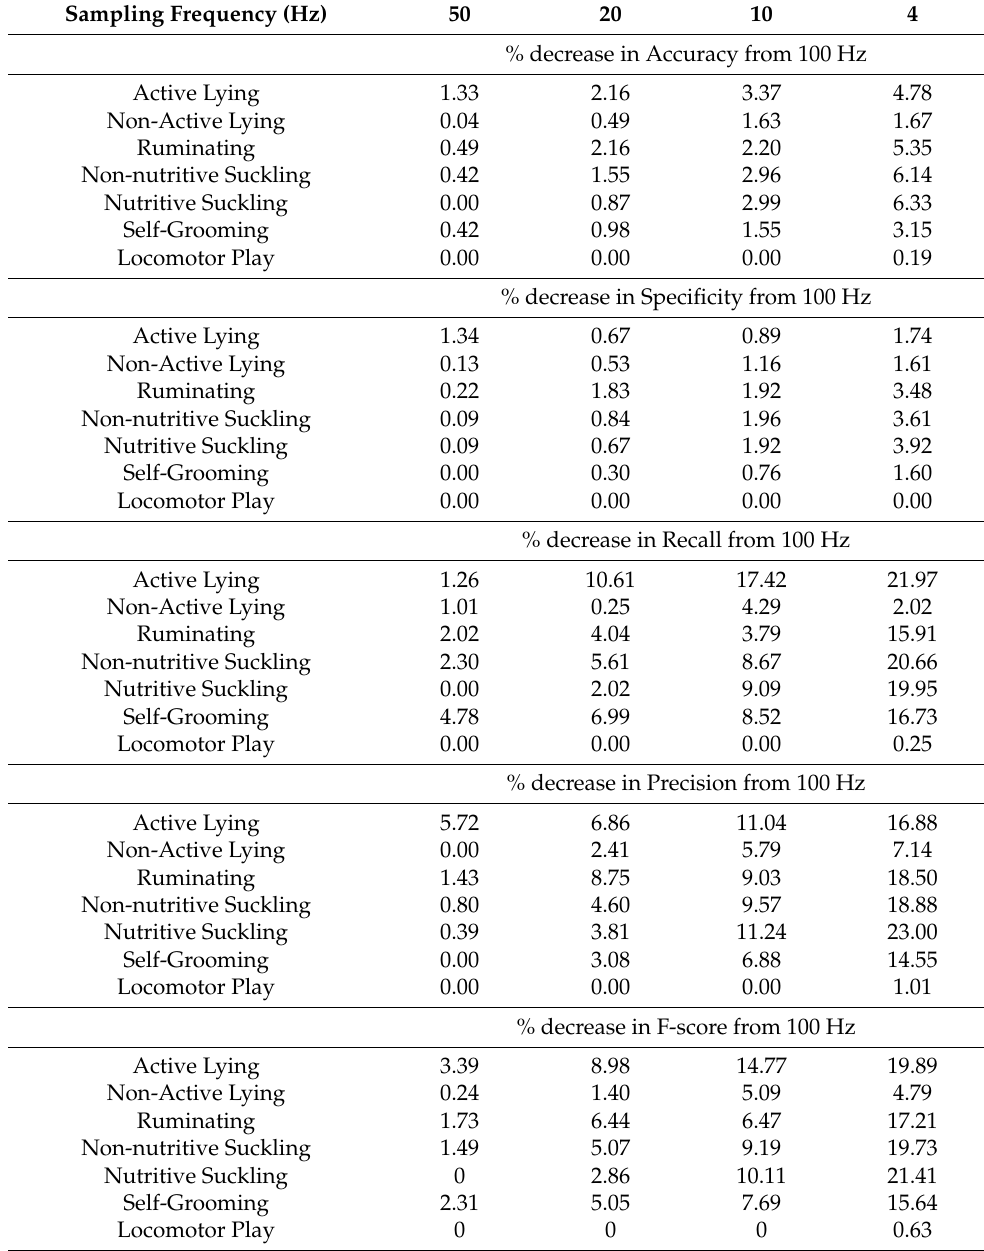
Table 3. Percentage decrease in algorithm performance by behaviour when down-sampling from 100 Hz to 50 Hz, from 100 Hz to 20 Hz, from 100 Hz to 10 Hz and from 100 Hz to 4 Hz. Sampling Frequency